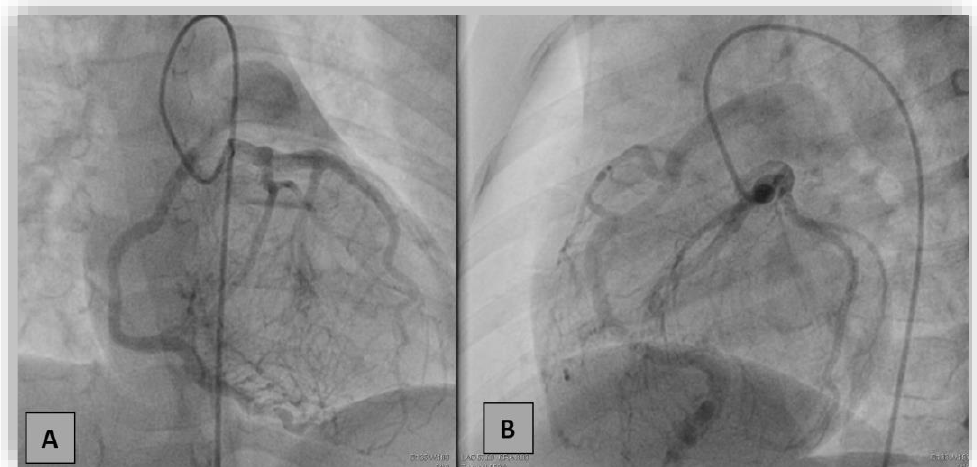
Figure 4. Coronarography in the right anterior oblique with cranial angulation ( A ) and left lateral oblique with caudal angulation ( B ) projections. Selective injection in the left coronary artery showed dilated left coronary artery and branches with a dense collateral network directed towards the right coronary artery (RCA), retrogradely filling RCA and the pulmonary artery.